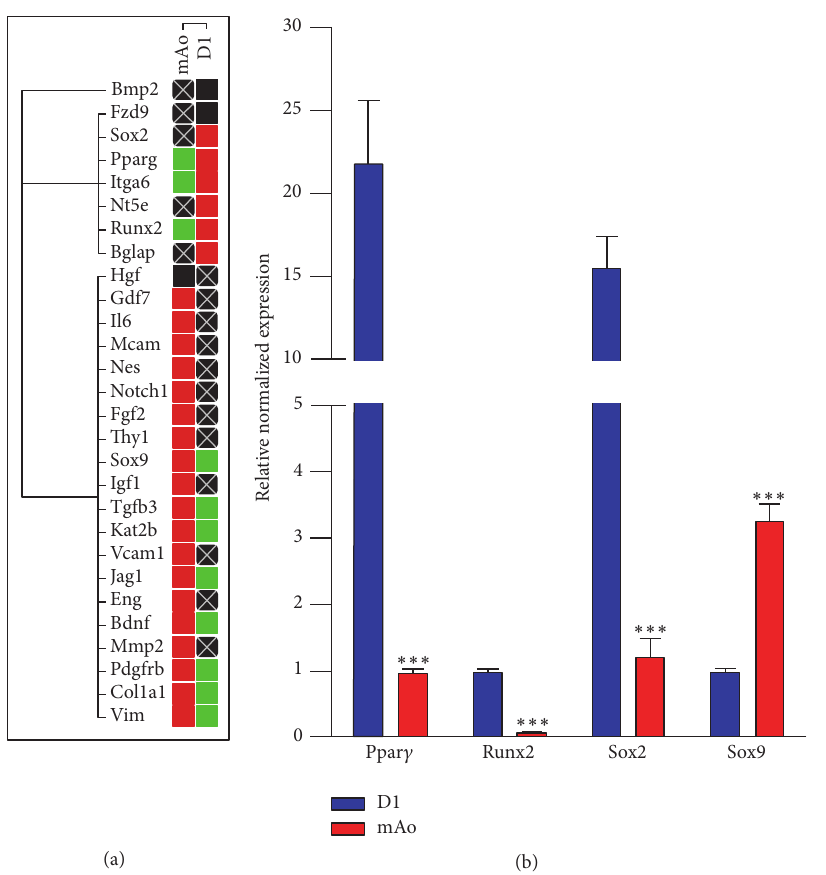
Figure 4: Mesenchymal stem cell-associated genes differentially expressed in mAo and D1 progenitor cells. (a) Clustergram demonstrating differentially expressed genes after normalizing to Gapdh, Hprt, and Tbp as shown in Table 1. Relative expression is indicated in the order of the target genes with the lowest expression at the top of each cluster. Red indicates greater expression, green indicates lower expression, black indicates very low expression, and black with a white X indicates no expression (Cq ≥ 30). (b) Relative expression of the Ppar 𝛾 , Runx2, Sox2, and Sox9 transcription factors in mAo and D1 progenitor cells using the Gapdh gene to normalize. Data are presented as mean ± SD, 𝑛 = 3 separate experiments. Significant differences were determined using 𝑡 -test. ∗∗∗ 𝑃 < 0.0001